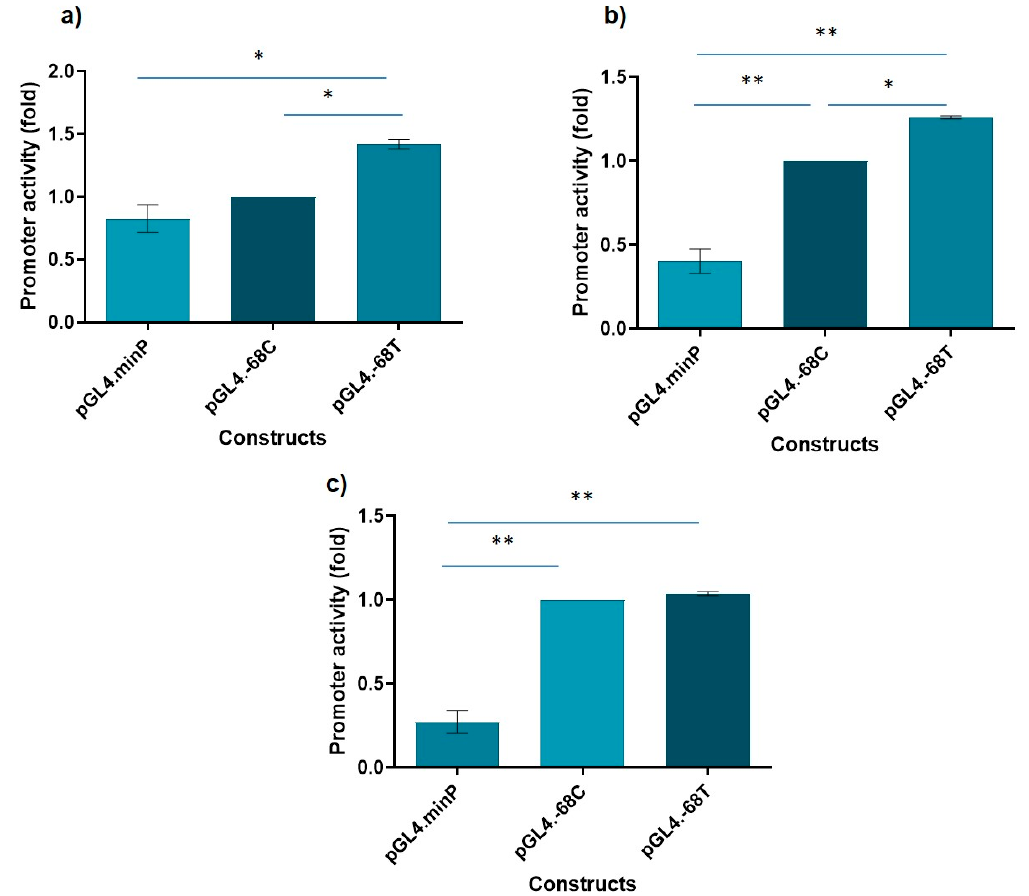
Figure 4. The c.-68C > T CLSPN promoter variant increases transcriptional activity in HEK293 and HeLa cell lines. After cloning a 150 bp fragment of the CLSPN promoter containing the variant into a minimal promoter (minP) vector, luciferase assays were performed to assess the transcriptional activity associated with each allele. A higher transcriptional activity was observed for the T allele in HEK293 ( a ) and HeLa ( b ) cells. No significant differences were observed in U2 OS cells ( c ). Experiments were performed three times independently and in triplicate. All data were combined for statistical analysis. * p < 0.001; ** p < 0.0001.